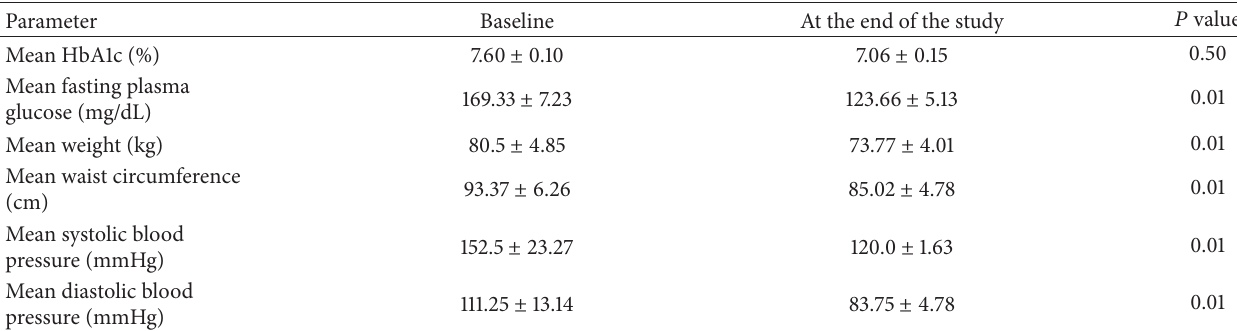
Table 3: Effect of isotretinoin (13- cis -retinoic acid) on clinical and biochemical parameters in responsive